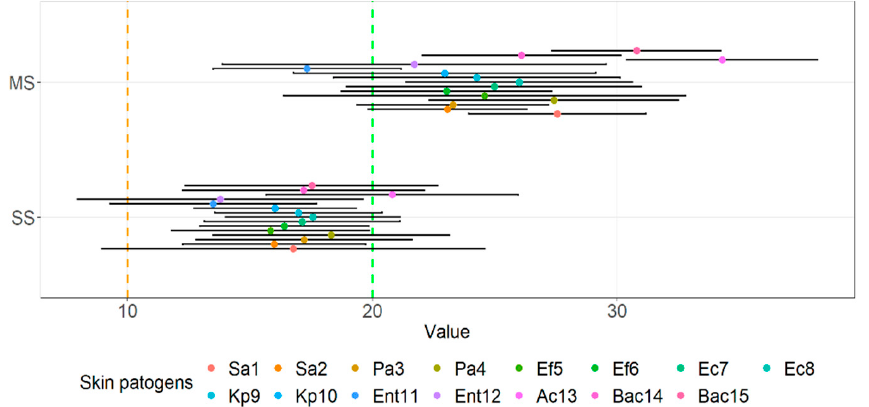
Figure 3. Means of inhibition zone together with 95% CI of multi-strain and single-strain probiotics against clinical skin pathogens using the agar spot assay.